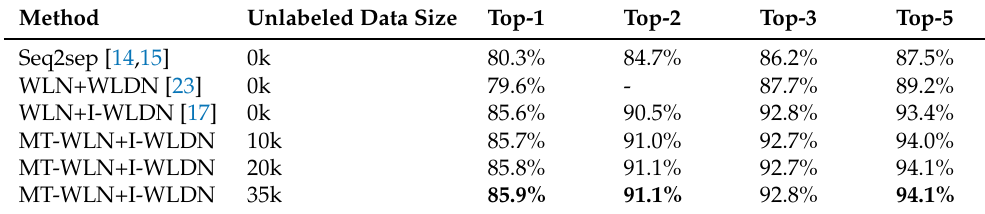
Figure 1. The number of reaction centers gained from the USPTO train/test/validation datasets. There are only few reactions which include 6 reaction centers. Table 1. Prediction accuracy of some methods. Top- k accuracy means that, if an algorithm proposes k potential products with the highest confidences, the probability that the corresponding ground-truth product is within these k